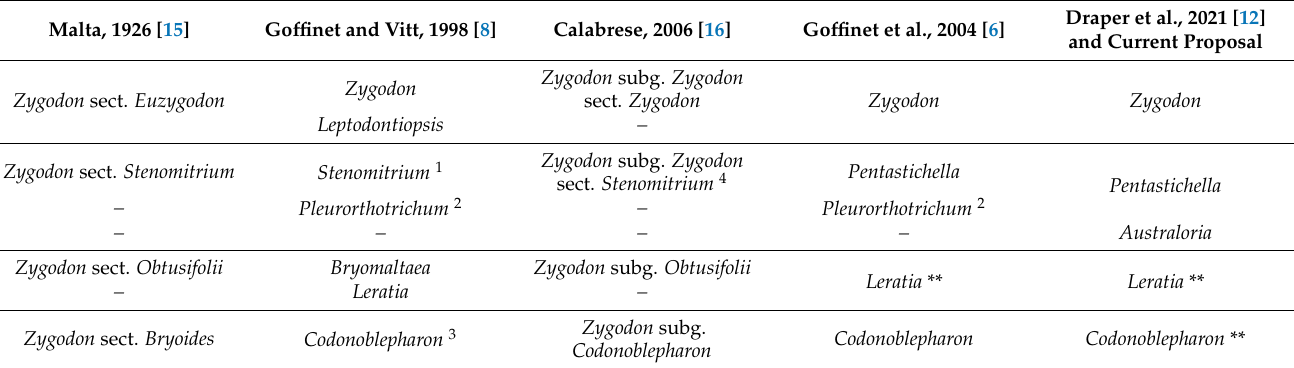
Table 3. Evolution of the classification of Zygodon and related genera since Malta [15]. Genera not considered as belonging to tribe Zygodonteae in the respective study are marked with two asterisks